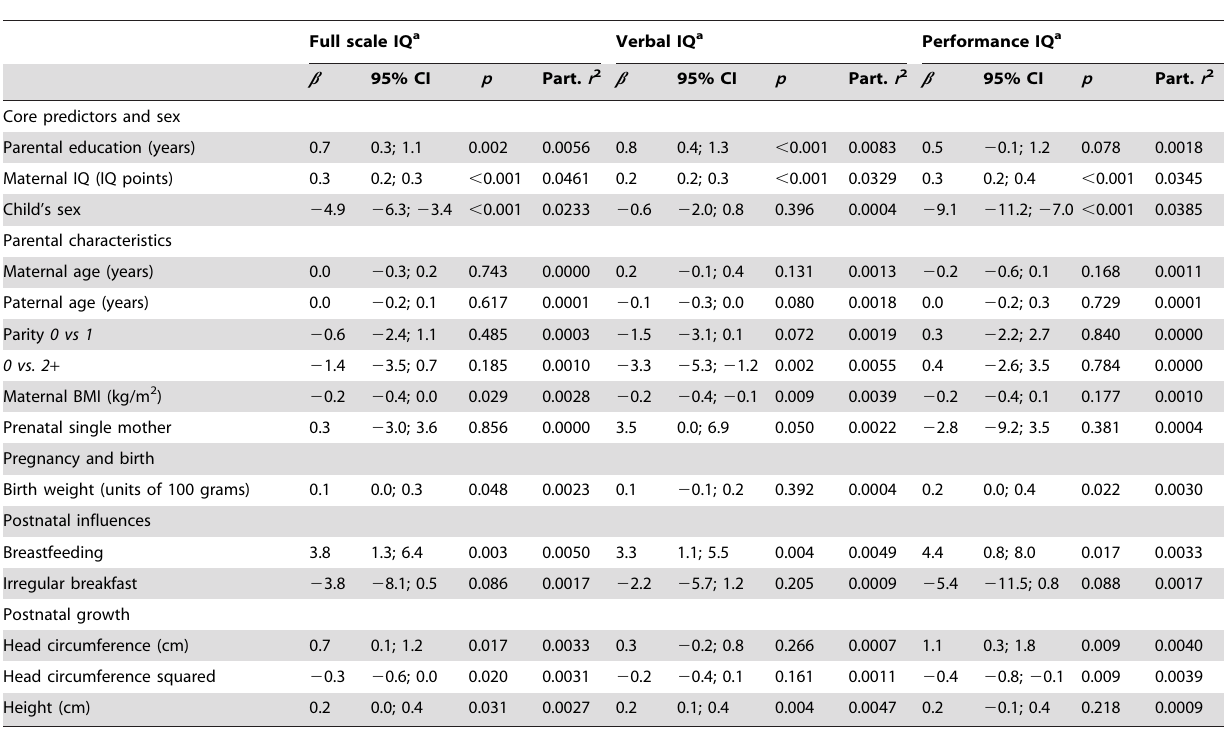
Table 3. Selected predictor variables and WPPSI-R scores, Denmark